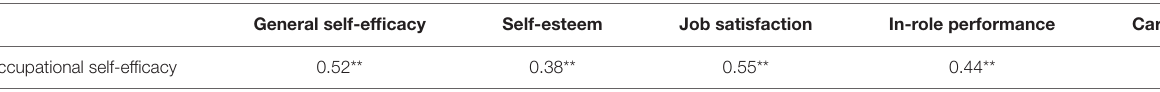
TABLE 3 | Correlation analysis between occupational self-efficacy and criterions ( n = 433). General self-efficacy Self-esteem Job satisfaction In-role performance